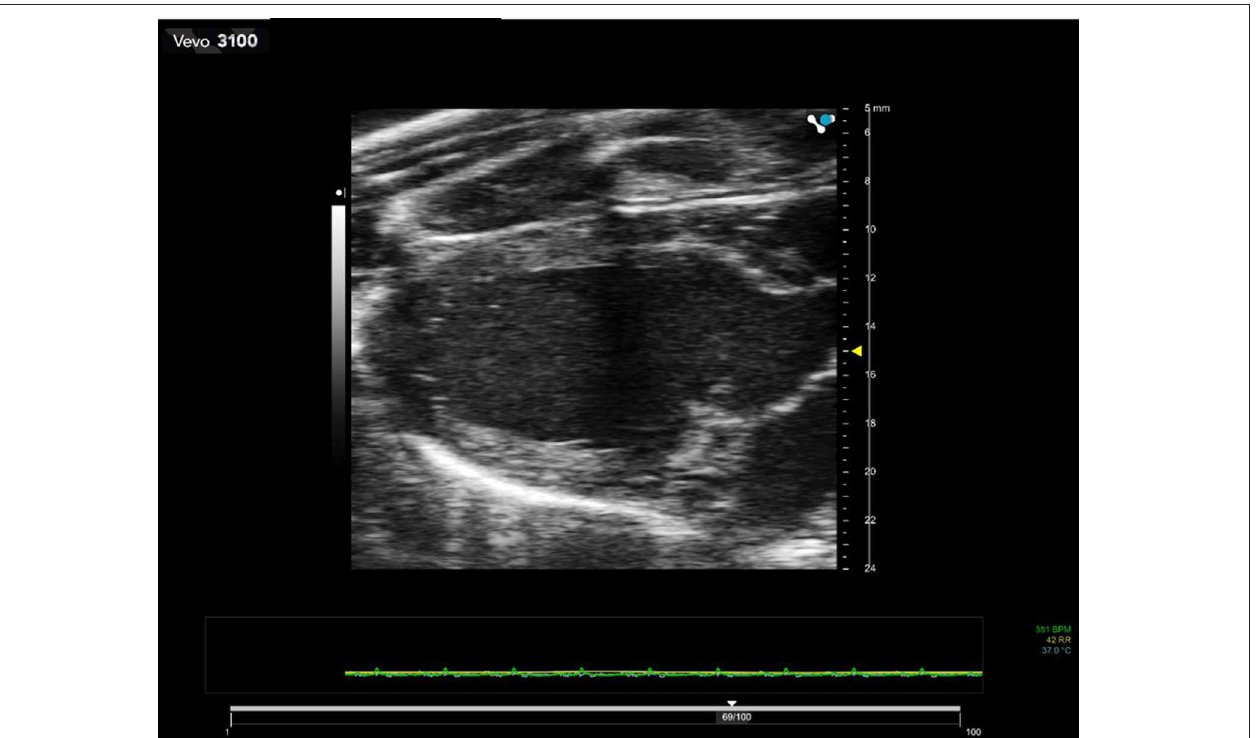
FIGURE 1 | 2D B-mode image of a rat heart in diastole. Transducer used is 21 MHz center-frequency and focus of the beam is set at 15mm depth. The dark zone running through the center of the image is caused by shadowing from the